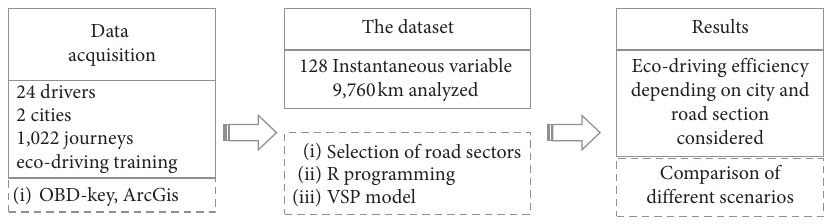
Figure 1: Research